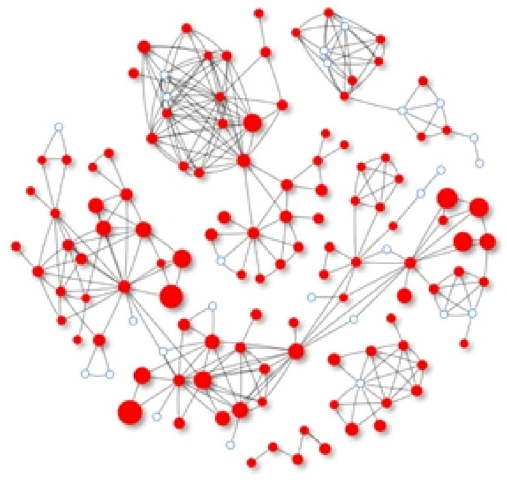
Figure 1. The acquaintance networks of the participants who contributed contact diaries for analysis in the study. The 113 participants who we identify as playing the role of ego appear as red solid nodes. The sizes of the red nodes are proportional to the frequencies in which they appeared as an ego in the 963 triplets of ego, degree-1 alter, and degree-2